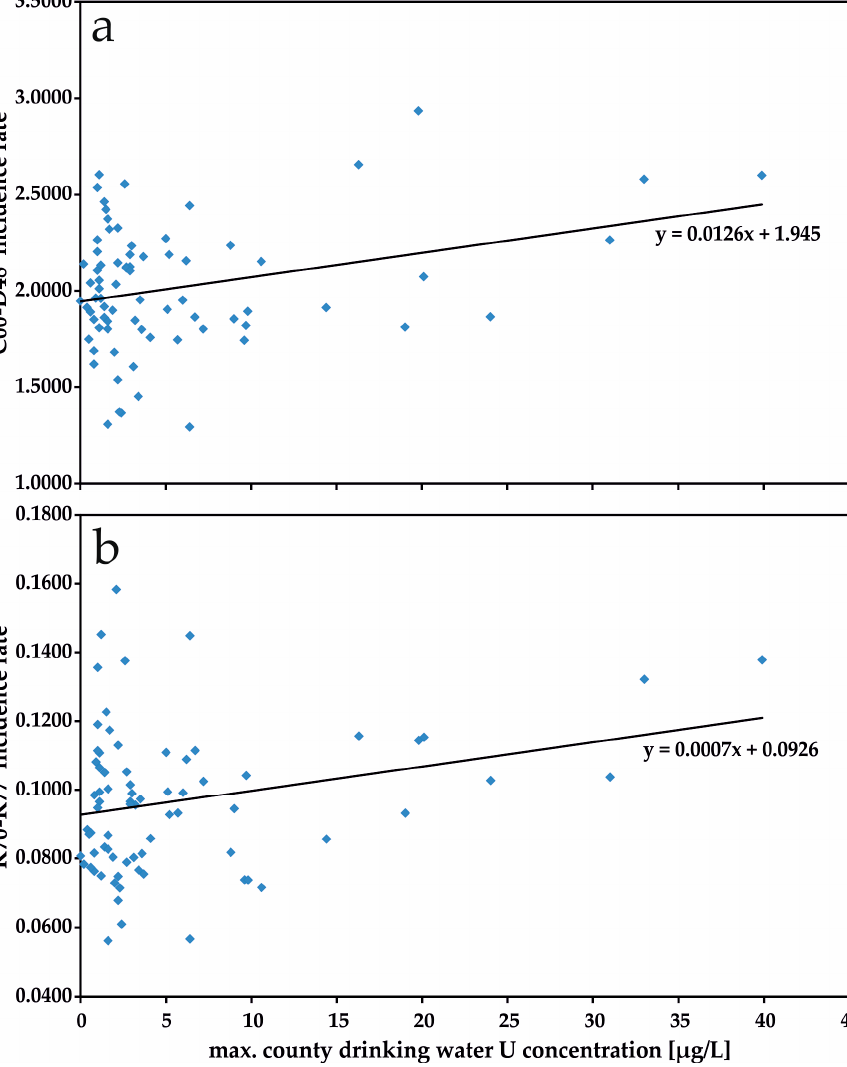
Figure 1. Bivariate correlations of maximum U concentrations in drinking water and diseases groups incidence rates. ( a ) C00-D48; ( b ) K70-K77.